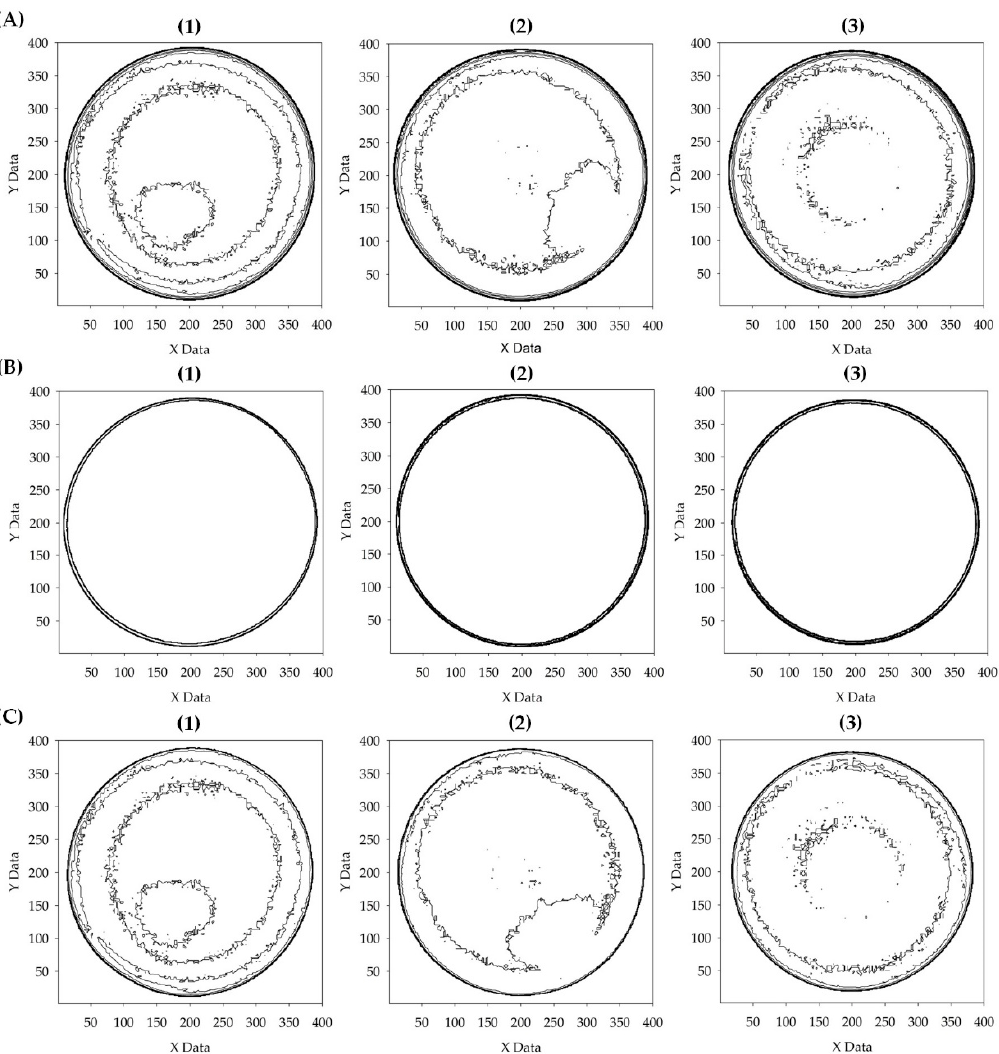
Figure 4. Diagrams of stratification analysis of axial plane imaging data of eggs of different qualities for ( A ) whole egg, ( B ) shell, and ( C ) inner egg. Stratification analysis of data visualization of axial plane images of (1) SO egg, (2) GO egg, and (3) CO egg.